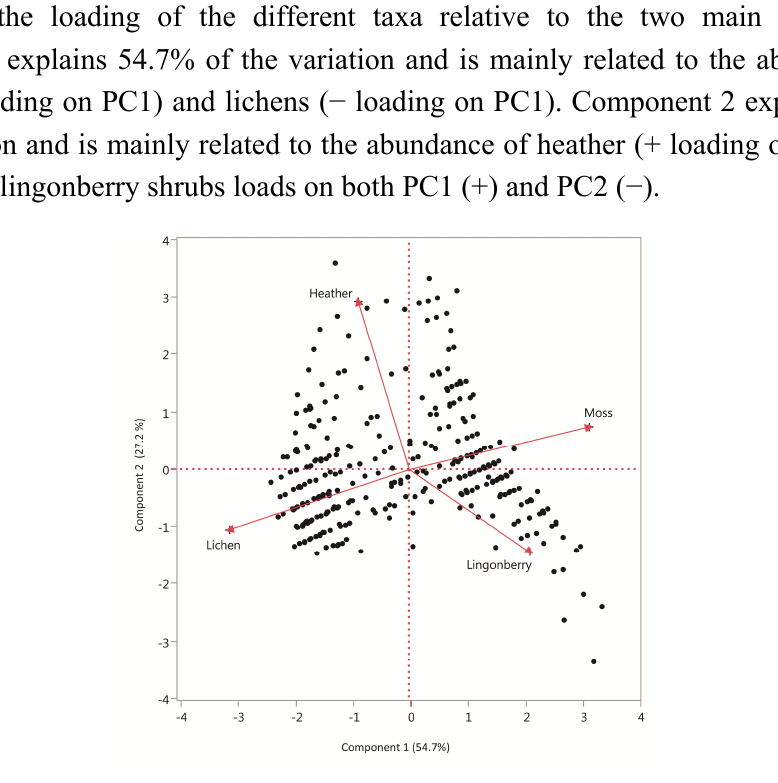
Figure 3. The subdivision of vegetation covariates into the two main principal components subsequently used in mixed model analyses on pine seedling establishment and growth along transects going from inside the forest into forest gaps. Arrows give the strength and direction of the loading of the different taxa relative to the two main components.